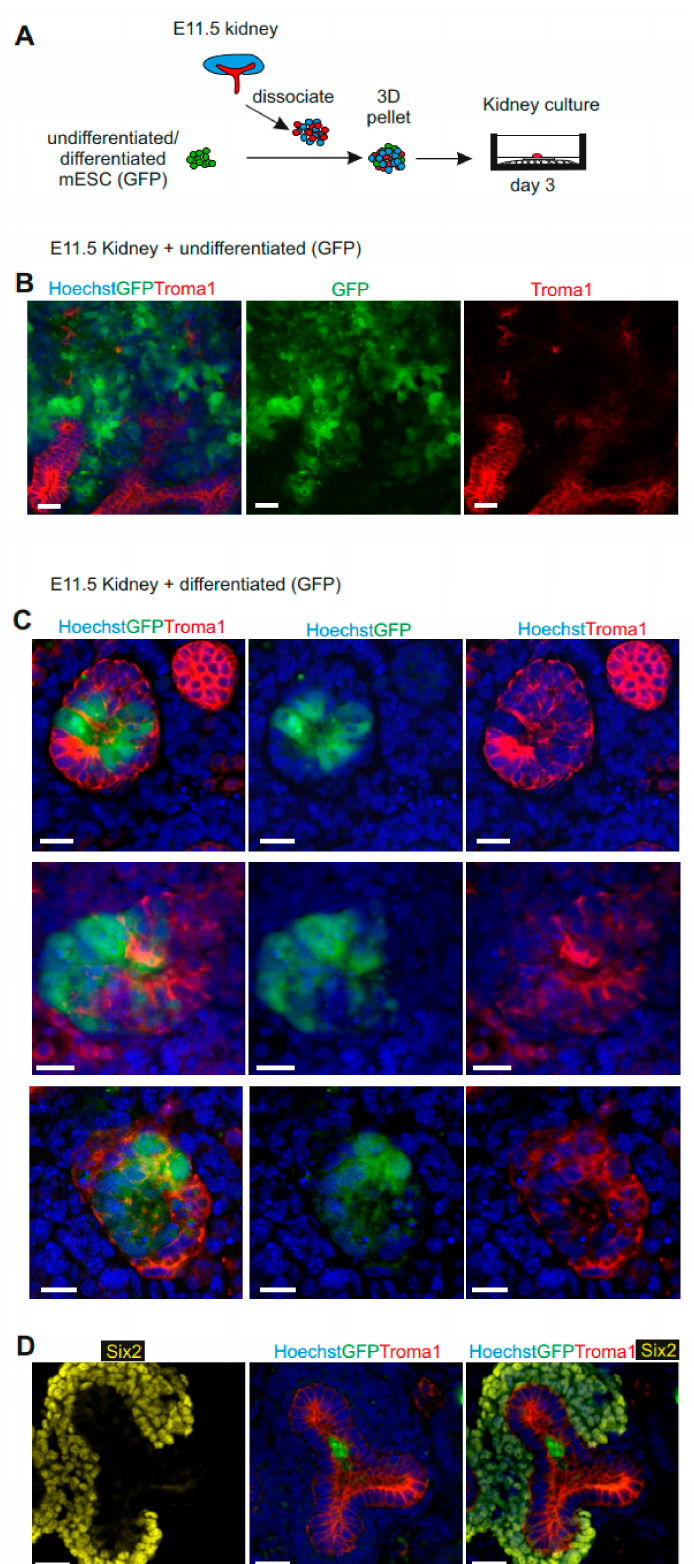
Figure 4. Mouse ESC-derived UB progenitor cells form anembryonic UB in 3D organ culture in vitro. ( A ) Schematic of kidney organoid generation from mESC-derived UB progenitors with mouse E11.5-dissociated kidney rudiments. ( B ) Immunofluorescence analysis demonstrating